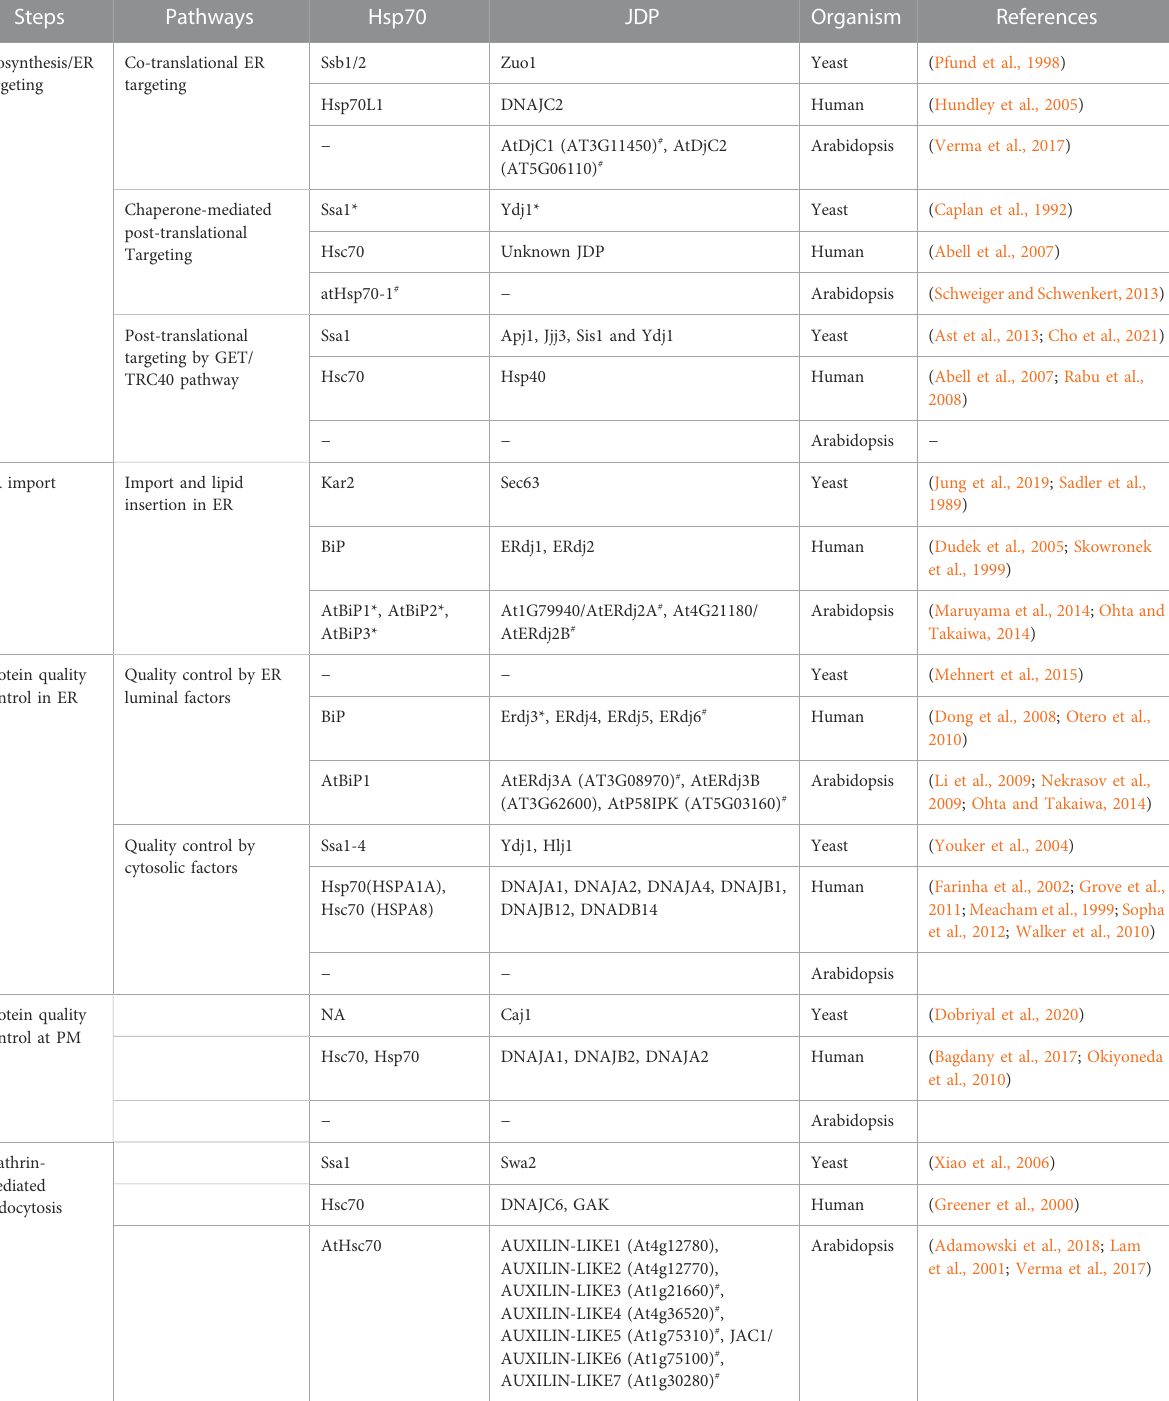
TABLE 2 List of JDPs in mediating the PQC of PM proteins in yeast, human, and Arabidopsis.